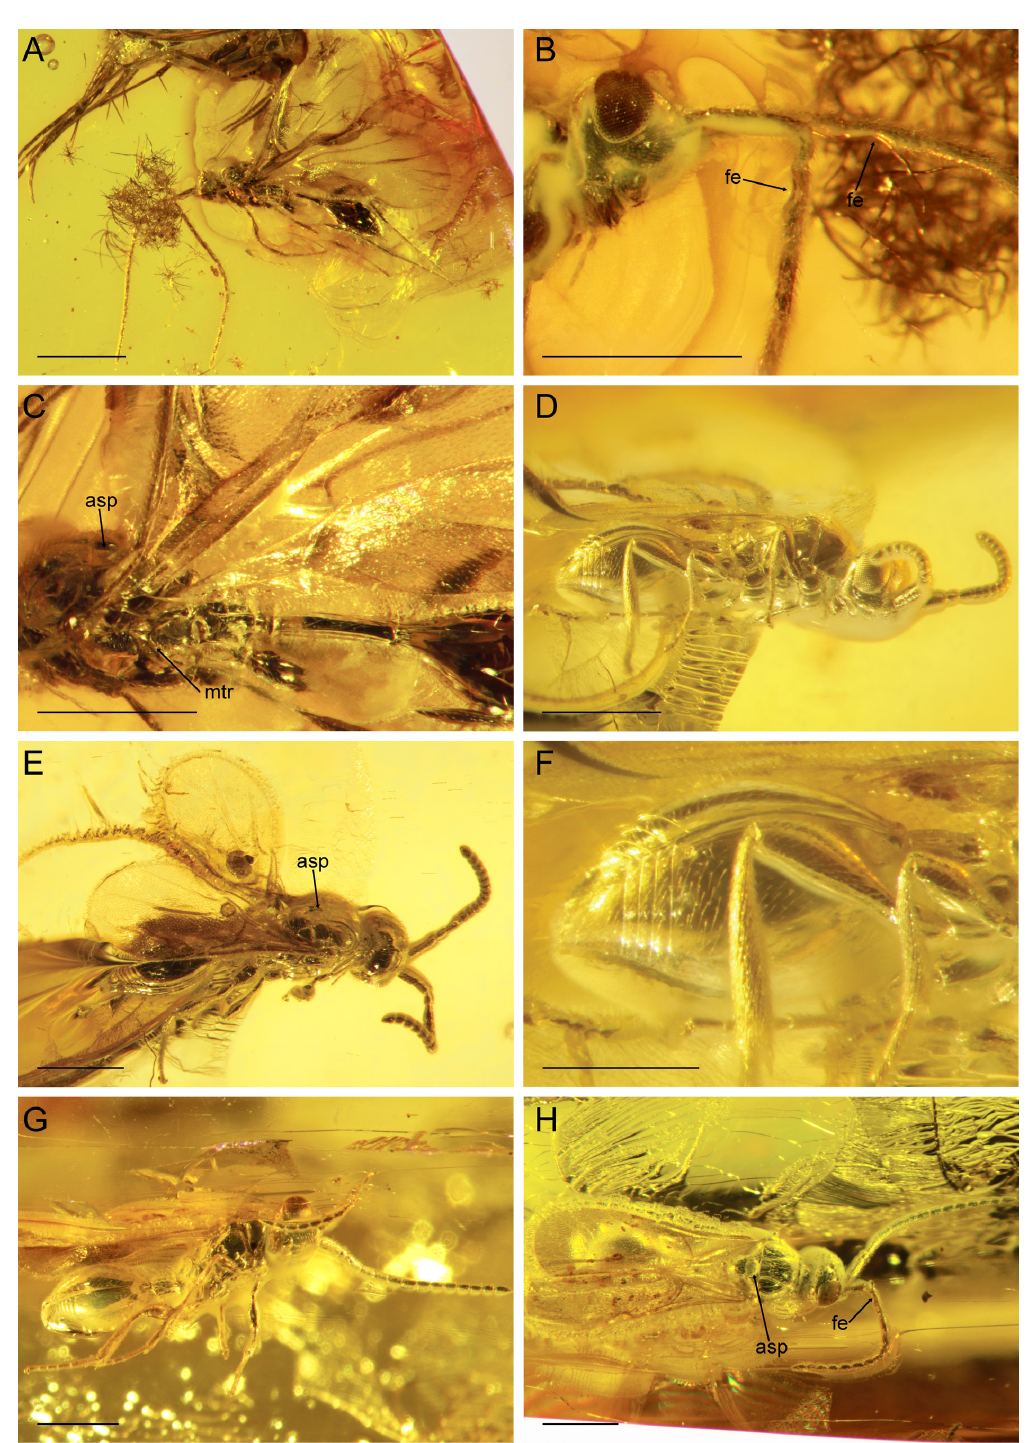
Fig. 3. A–C . Cinetus elongatus sp. nov., holotype (NHMD-608402). A . Habitus in lateral view. B . Head in lateral view. C . Mesosoma and petiole in lateral view. D–H . Pantoclis globosa sp. nov. D–F . Holotype (NHMD-608414). D . Habitus in lateral view. E . Habitus in dorsal view. F . Gaster in lateral view. G–H . Paratype (NHMD-608394). G . Habitus in lateral view. H . Habitus in dorsal view. Abbreviations: asp = anterior scutellar pit; fe = flagellomere emargination; mtr = metapleural ridge. Scale bars: A = 2 mm; B–E, G–H = 1 mm; F = 0.5